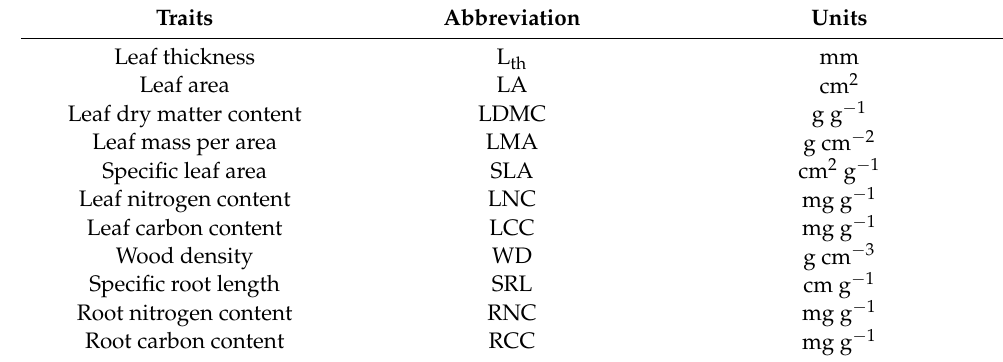
Table 1. Functional traits measured in this